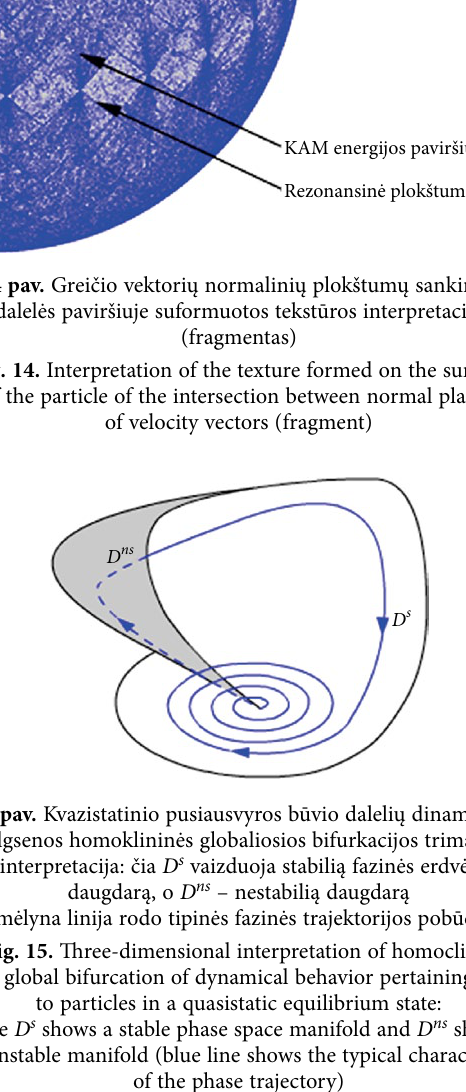
Fig. 13. Phase trajectories on the surface of two-dimensional energy torus: a – irrational ratio of angular frequencies; b – rational ratio of angular frequencies (resonant